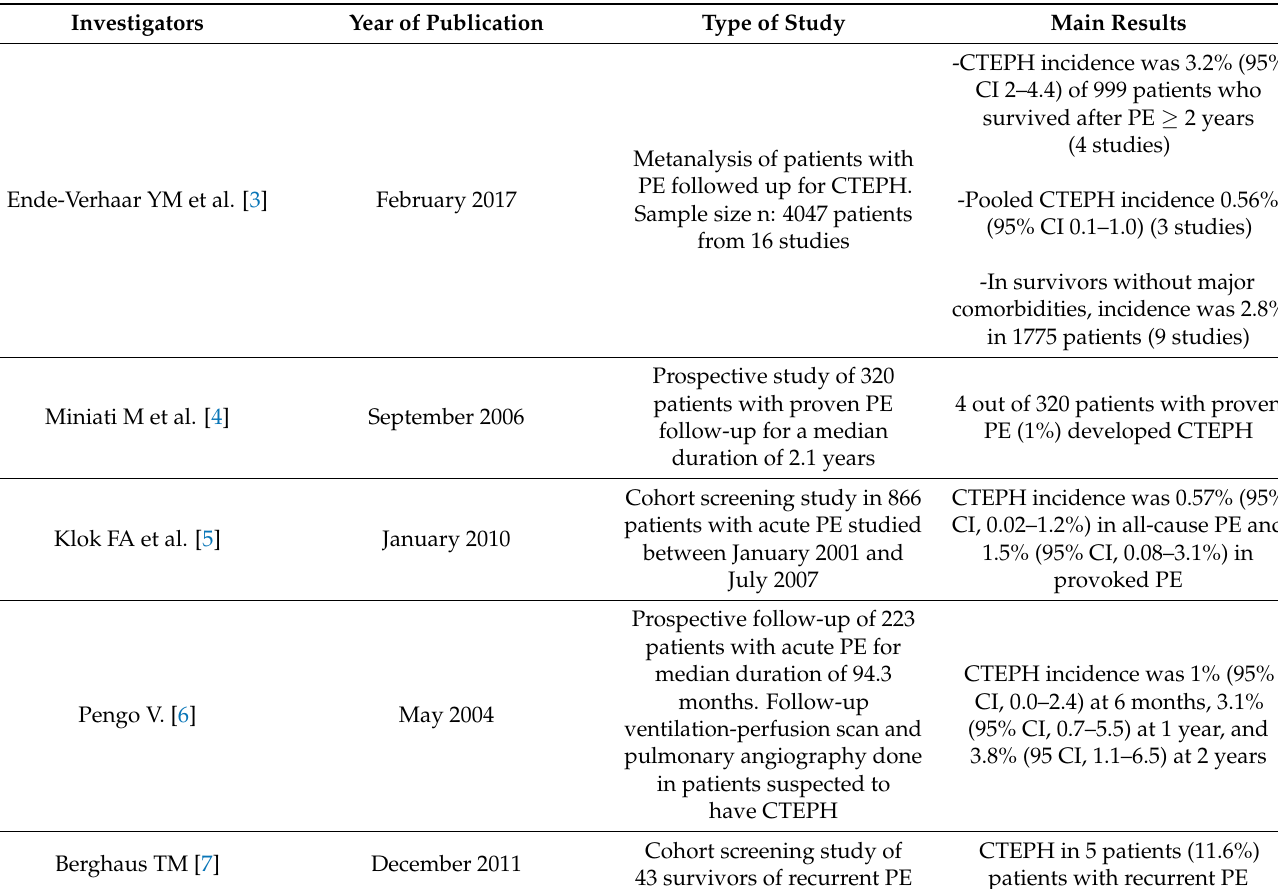
Table 2. Studies estimating incidences of chronic thromboembolic pulmonary (CTEPH) after pulmonary embolism (PE).